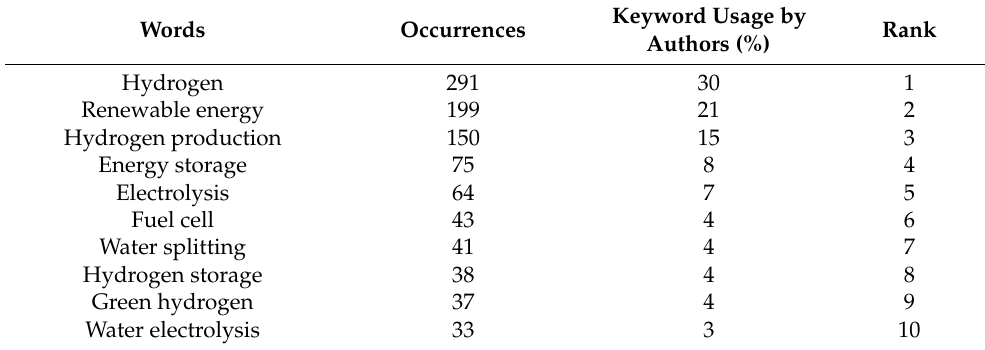
Table 4. Keyword